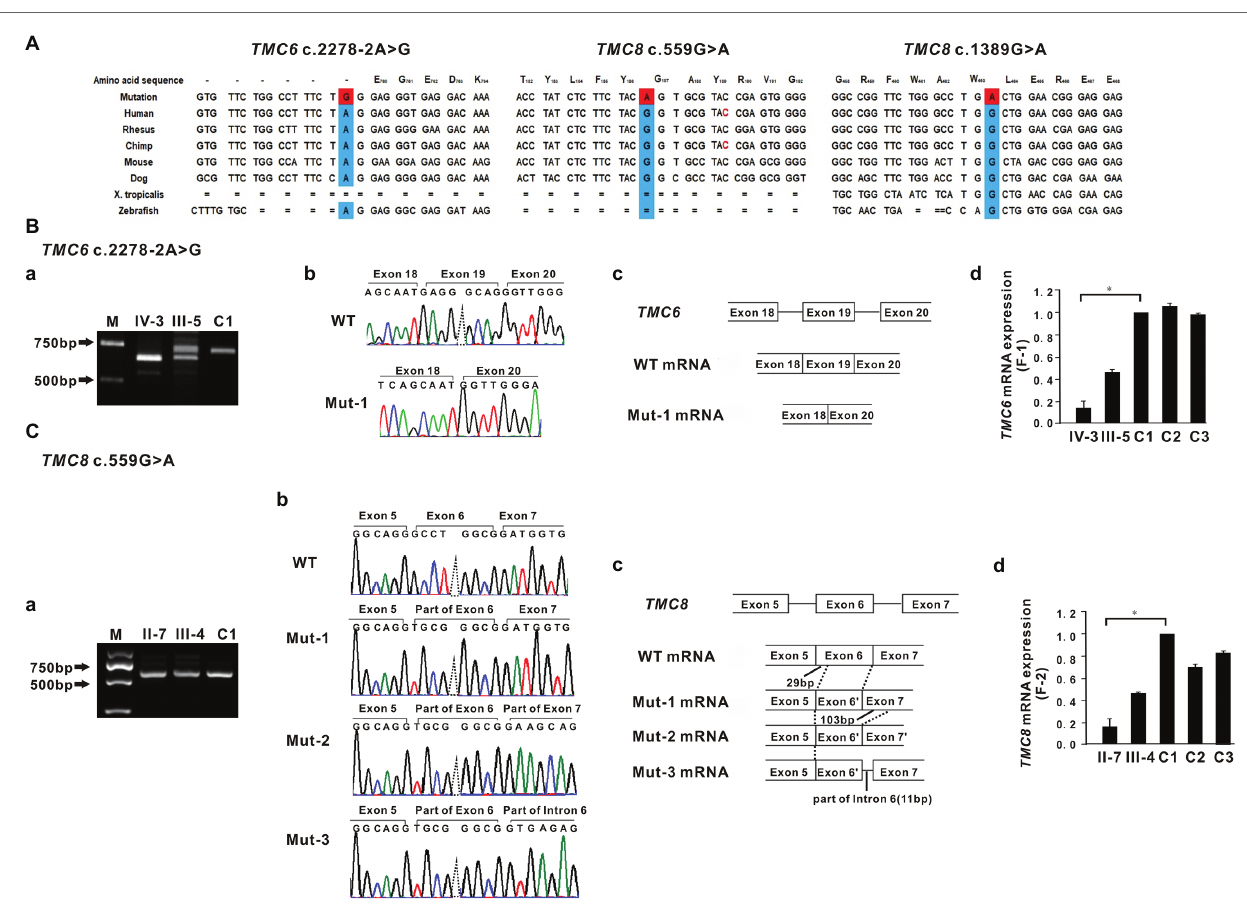
FIGURE 2 | Sequence conservation and functional analysis of the identified TMC6 and TMC8 variants. (A) All three variants, c.2278-2A>G in TMC6 , c.559G>A in TMC8 , and c.1389G>A in TMC8 , detected in the three affected individuals are evolutionarily conserved across different species. (B-a) RT-PCR of mRNA from peripheral blood lymphocytes from patient IV-3 (F1) yielded a shorter band than that of the control (C1), indicating an aberrant transcript. M, marker. (B-b) Sequencing traces of the RT-PCR products showing that the wild-type (WT, top) and TMC6 exon 19 skipped transcripts (Mut-1, bottom). (B-c) Schematic representation of exon 18 to exon 20 of TMC6 showing normal or aberrant splicing. The boxed regions denote exons, while the connecting solid lines indicate introns. (B-d) Quantitative RT-PCR (qRT-PCR) of the relative TMC6 mRNA expression in peripheral blood lymphocytes from the affected individual (IV), the heterozygous carrier (III-5), and the independent controls (C1, C2, and C3; right). (C–a) Bands approximately 650 bp in size were observed in both the proband II-7 and C1. (C-b) Sequencing chromatograms showed that the TMC8 c.559G > A variant had a novel acceptor splice site at c.561 and yielded three different aberrant transcripts (Mut-1, Mut-2, and Mut-3). (C-c) Schematic representation of the critical region of TMC8 showing normal or aberrant splicing. The solid black lines indicate the location and number of inserted or deleted nucleotides. (C-d) qRT-PCR of the relative TMC8 mRNA expression in peripheral blood lymphocytes from the affected individual (II-7), the heterozygous carrier (III-4), and the independent controls (C1, C2, and C3; right). For all qRT-PCR assays, glyceraldehyde 3-phosphate dehydrogenase (GAPDH) was used as an endogenous control. C1 was set to 1.0, and data are presented as the mean ± SD ( n ≥ 3, * p <